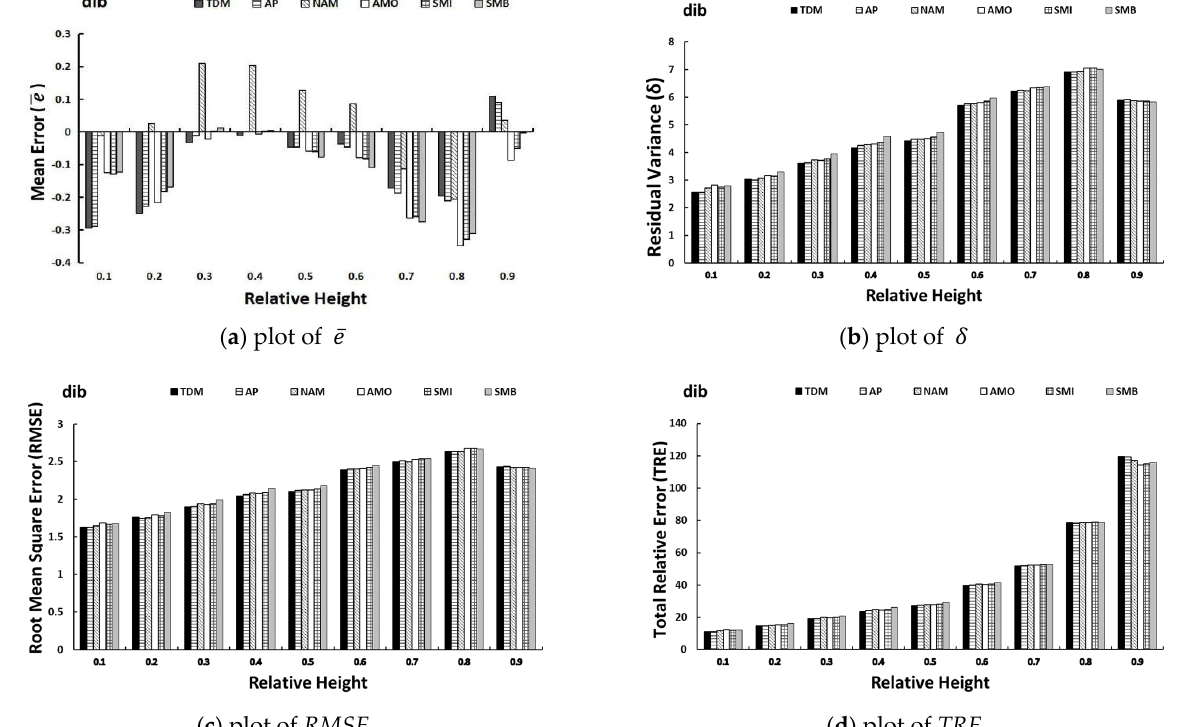
Figure 4. Plots of evaluation statistics from six methods against relative height classes for dib.